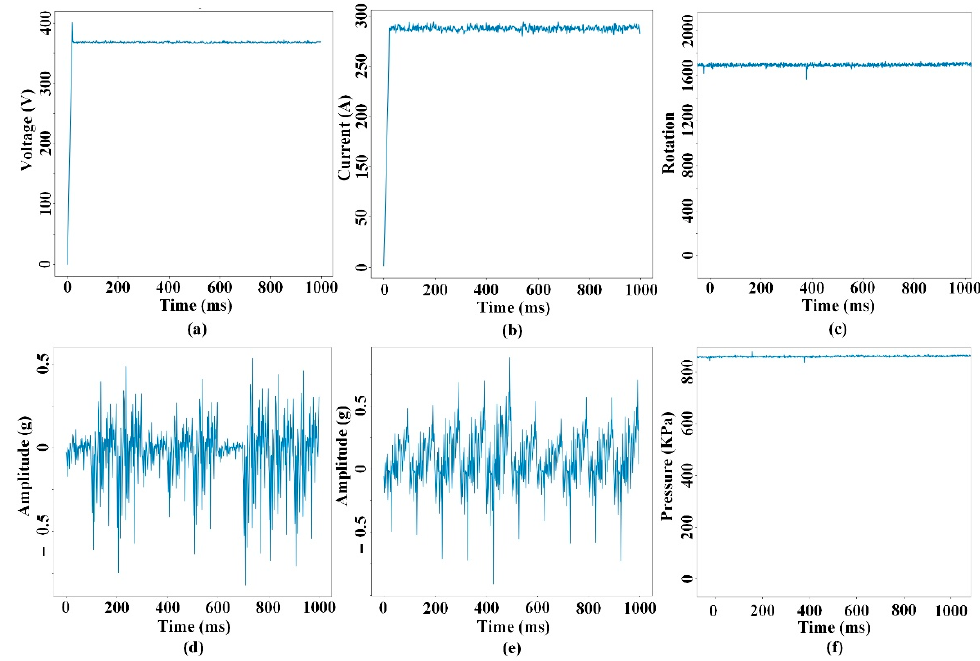
Figure 7. The preprocessed dataset of multi-sensor signals. Subplots ( a – f ) are signals of voltage, current, rotation, vibration-x, vibration-y and pressure, respectively. Subplots ( a , b ) refer to the starting moment, and subplots ( c – f ) reflect the normal running state of corresponding equipment.